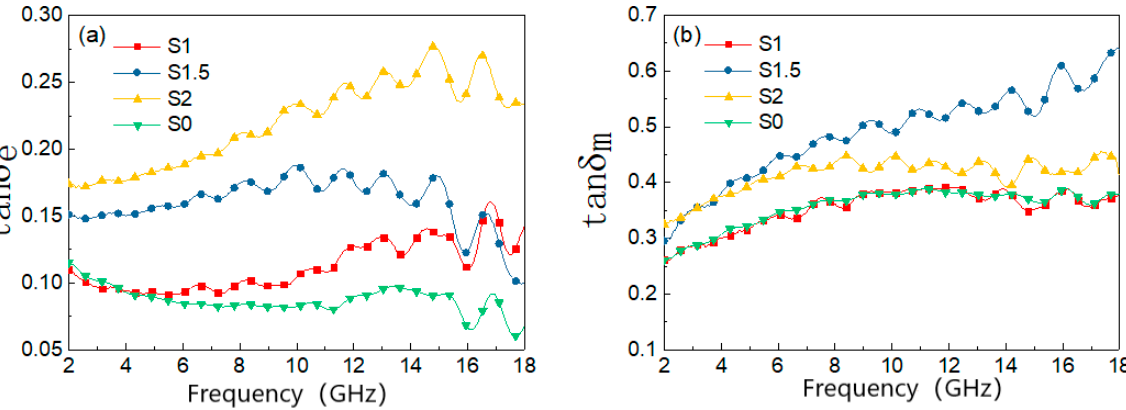
Figure 2. Dielectric and magnetic losses of composite materials. ( a ) Dielectric loss; ( b ) magnetic loss.